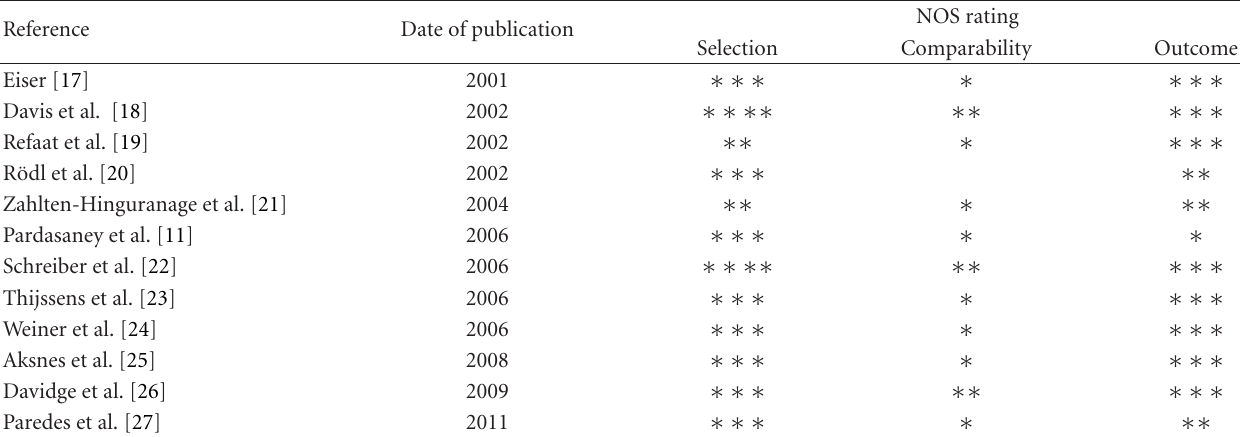
Table 1: Quality assessment of selected